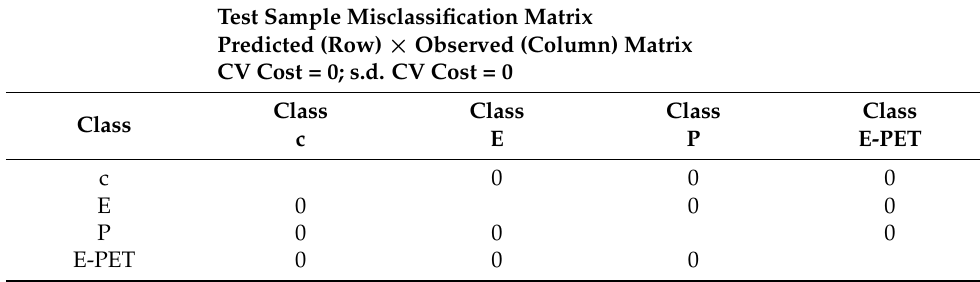
Table 10. Results of incorrect classifications for the test group